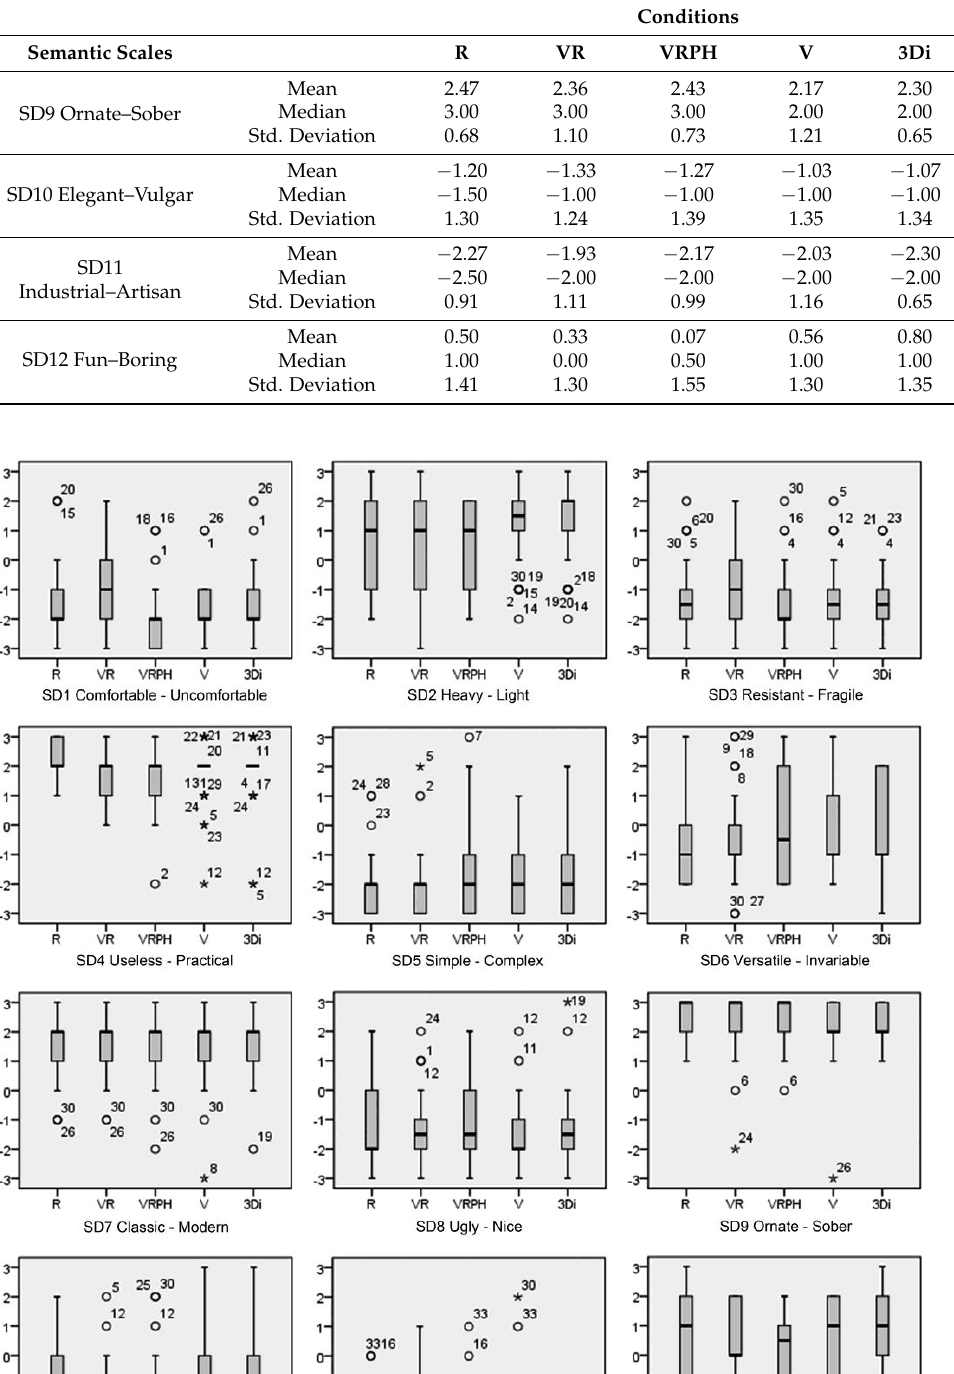
( c ) Figure 6. Box plot and histogram for the ( a ) “I like it” question, ( b ) sense of presence, and ( c ) con- fidence. Outliers outside 1.5 times the interquartile range above the upper quartile and below the lower quartile are represented by an open circle. Extreme outliers are marked with an asterisk.